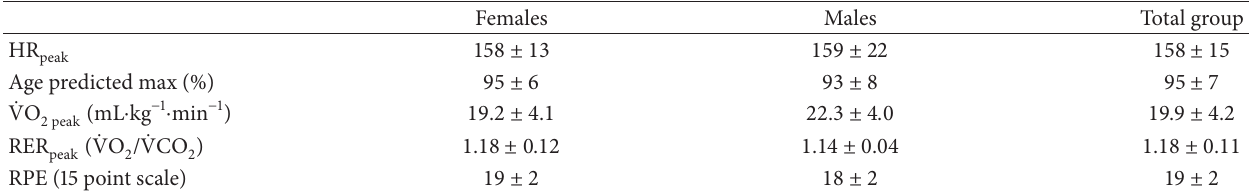
Table 2: Physiological variables from the maximal cycling ergometry test in 22 patients (17 females and 2 males).